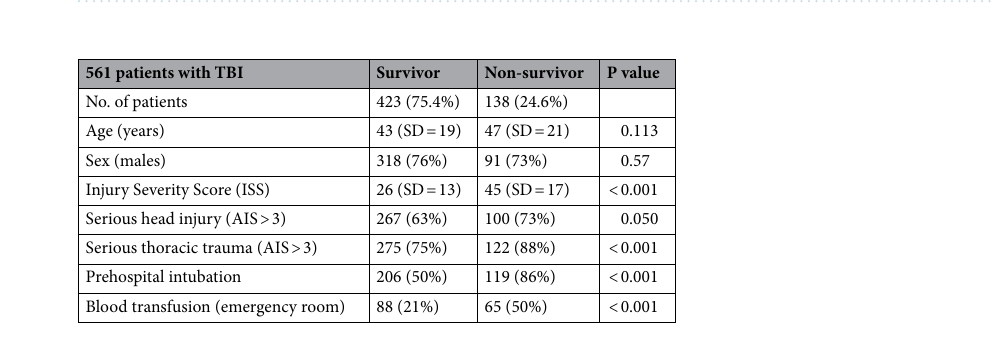
Table 5. Outcome of all patients and of all patients with tracheobronchial trauma (RISC II: Revised Injury Severity Classification Score).